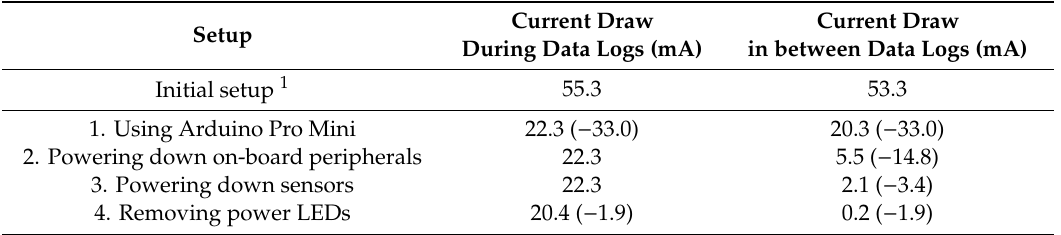
Table 1. Overview of the power saving measures and corresponding reductions in current draw during and in between data